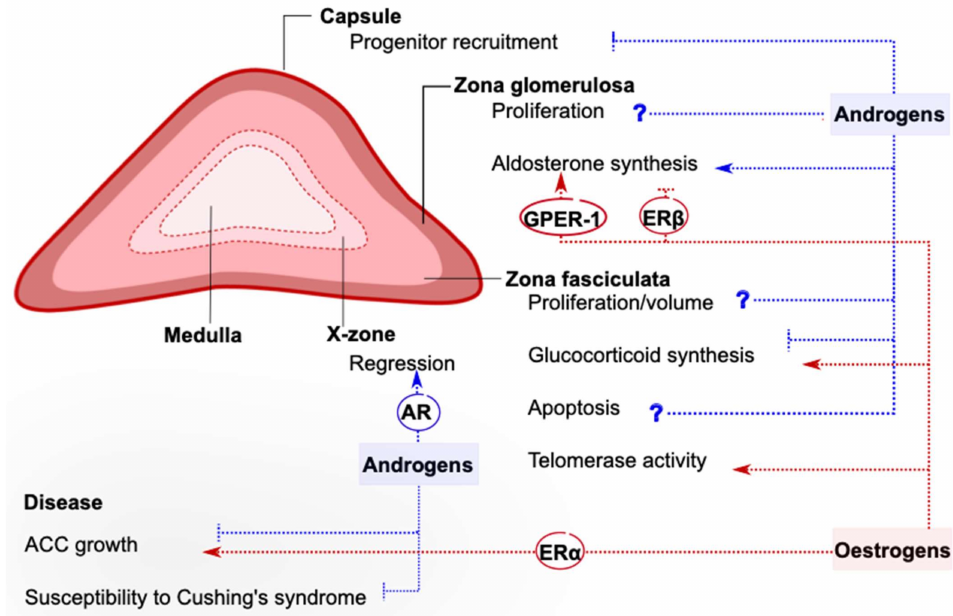
Figure 1. Reported effects of gonadal hormones on the mouse adrenal cortex. The sexual dimorphism characterizing many aspects of adrenal cortex physiology is attributed to circulating or locally produced androgens and estrogens, whose action can be inhibitory or stimulatory. Gonadal hormones can exert direct actions on the adrenal cortex, and sometimes the receptor responsible for initiating them has been recognized. In other cases, gonadal hormones act indirectly via inter- organ communication. Often, the effects of sex hormones are complex, and more research is needed to clarify their exact contribution (marked by a question mark). This figure summarizes knowledge derived from in vitro and rodent studies. AR: Androgen receptor, ER α : estrogen receptor α , ER β : estrogen receptor β , GPER-1: G-protein-coupled estrogen receptor 1, ACC: adrenocortical